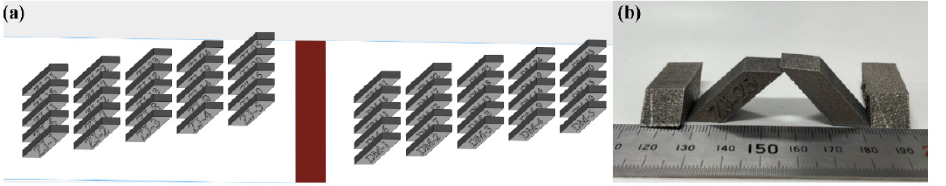
Figure 2. ( a )The as-designed LPBF–AlSi10Mg samples and ( b ) the as-built AlSi10Mg